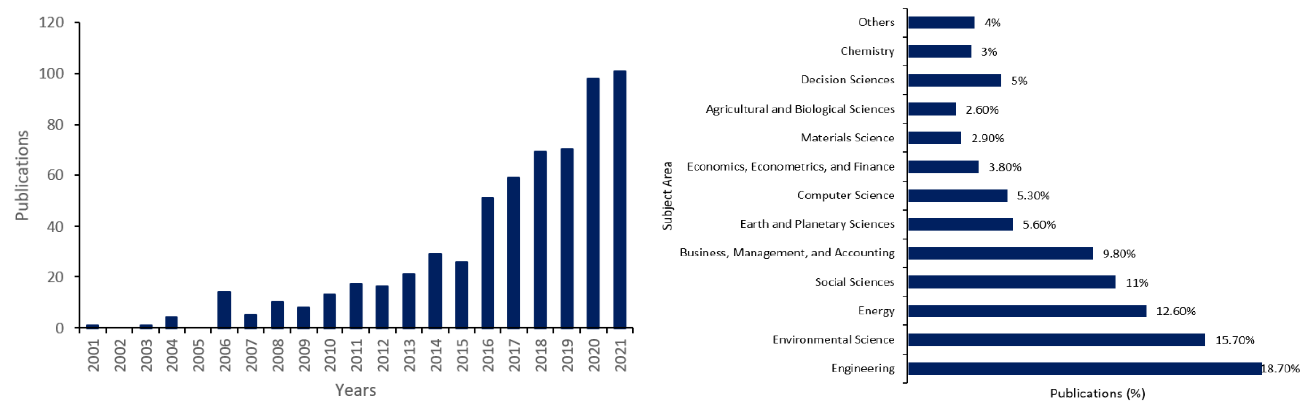
Figure 2. Annual Published Research in Sustainability and Sustainable Development per Subject Area in the UAE [123].